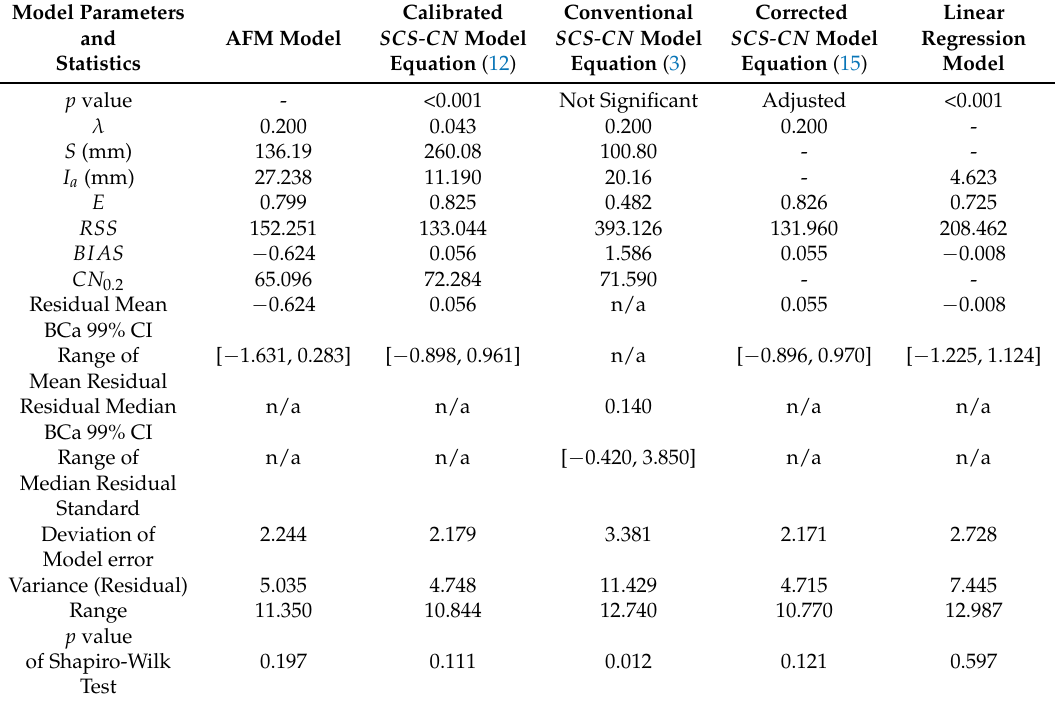
Table 3. Descriptive statistics of five runoff predictive